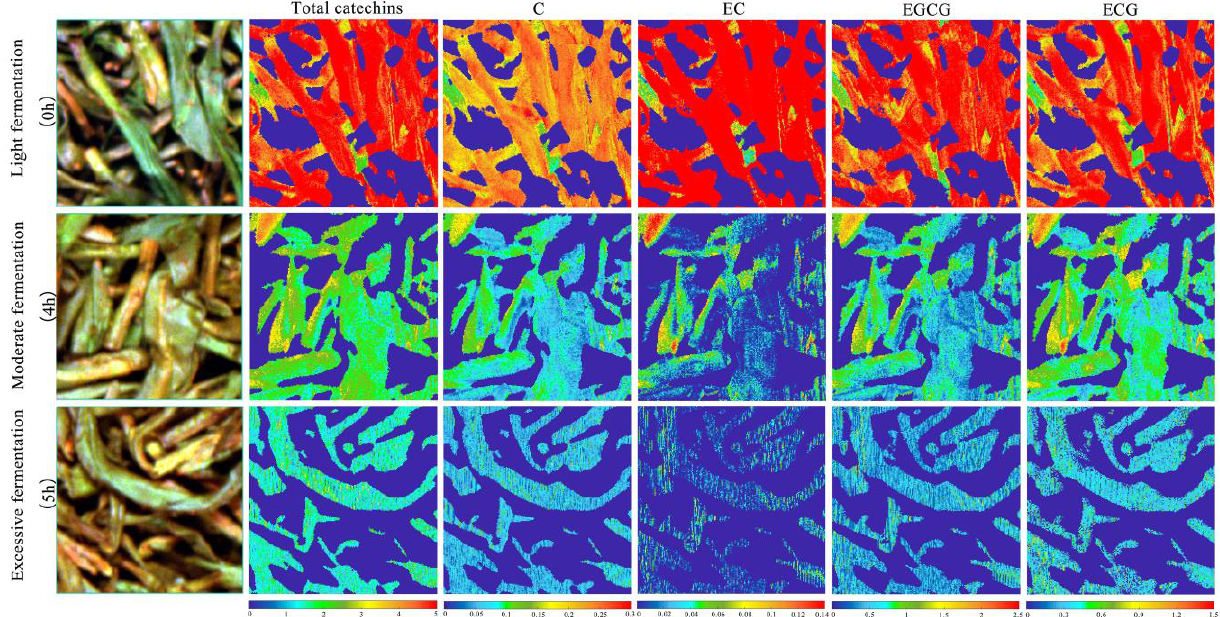
Figure 6. The visual analysis chart of catechin content for different fermentation